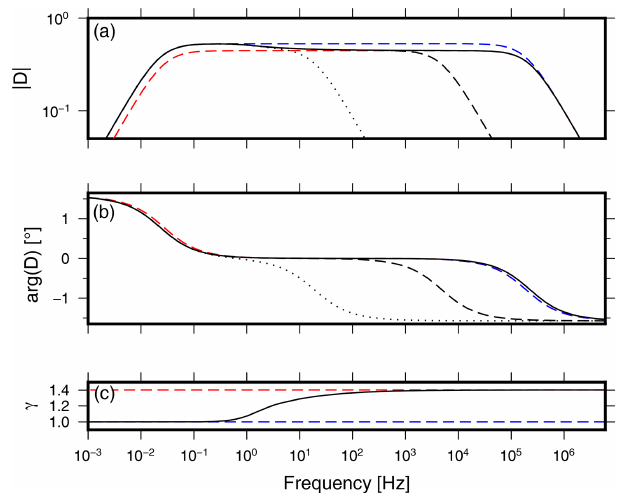
Figure 3. The theoretical sensor frequency response function for (a) amplitude and (b) phase in the case of isothermal and adia- batic gas behavior in blue and red, respectively. The solid black line indicates the corrected sensor response by γ (c) , as discussed in Sect. 3.1.3. The dotted and dashed lines indicate the high-frequency shifting cutoff due to R gore , as discussed in Sect.